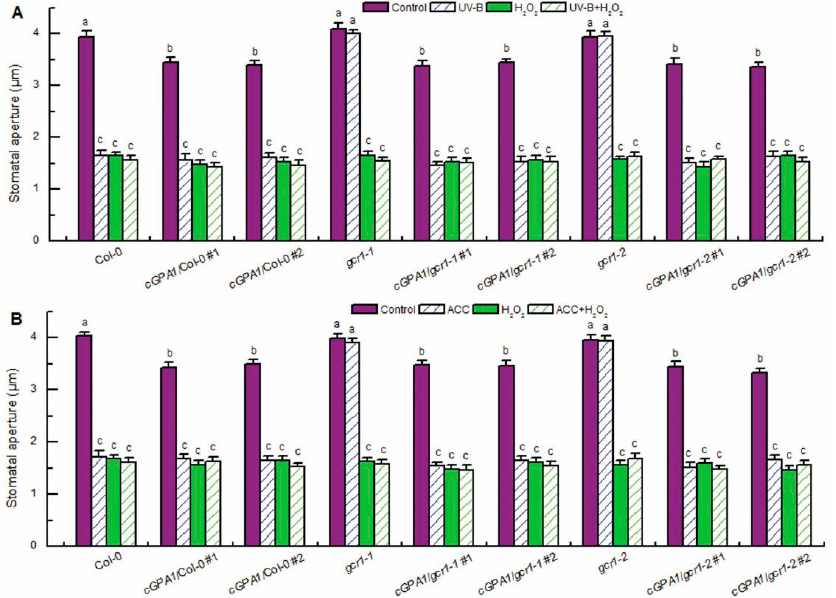
Figure 4. Exogenous H 2 O 2 induced stomatal closure in the gcr1 mutants and cGPA1 transgenic plants in the absence or presence of UV-B or ACC. Leaves of the wild-type Col-0, gcr1 mutants, and transgenic plants cGPA1 /Col-0/ gcr1-1 / gcr1-2 with open stomata were floated on MES buffer in the absence or presence of 100 μ mol/L H 2 O 2 (H 2 O 2 ) under light alone (Control) or with 0.5 W/m 2 UV-B (UV-B) ( A ) or the MES buffer containing 100 μ mol/L ACC (ACC) ( B ) for 3 h. Then stomatal apertures were measured in epidermal strips. Data are shown as means ± SE ( n = 3), each with 30 stomata. Means with different letters are significantly different at p < 0.01.